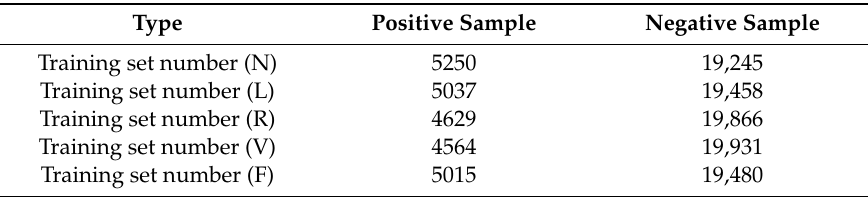
Table 10. Train set of the one versus rest support vector machine (OVR SVM).